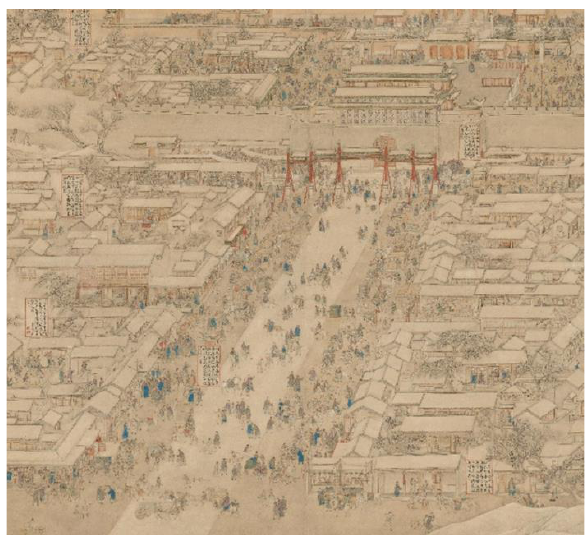
Figure 16. Zhengyang Street in "Spring Poems in the Capital" scroll painted by Xu Yang (Qing Dynasty)